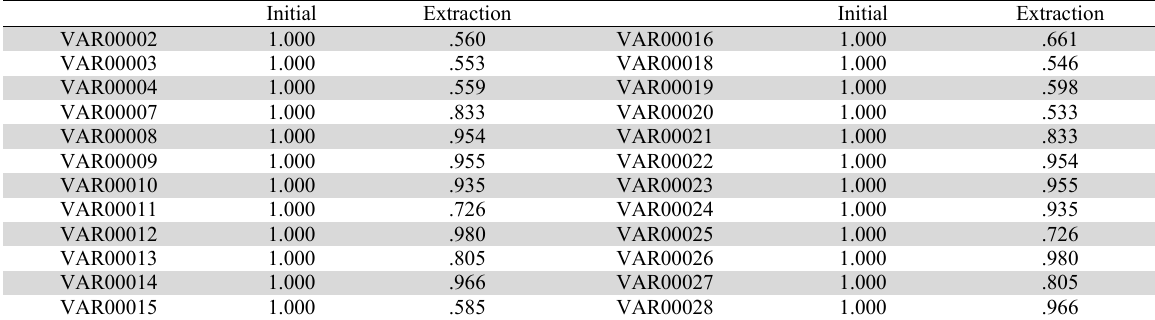
The summary of Communalities